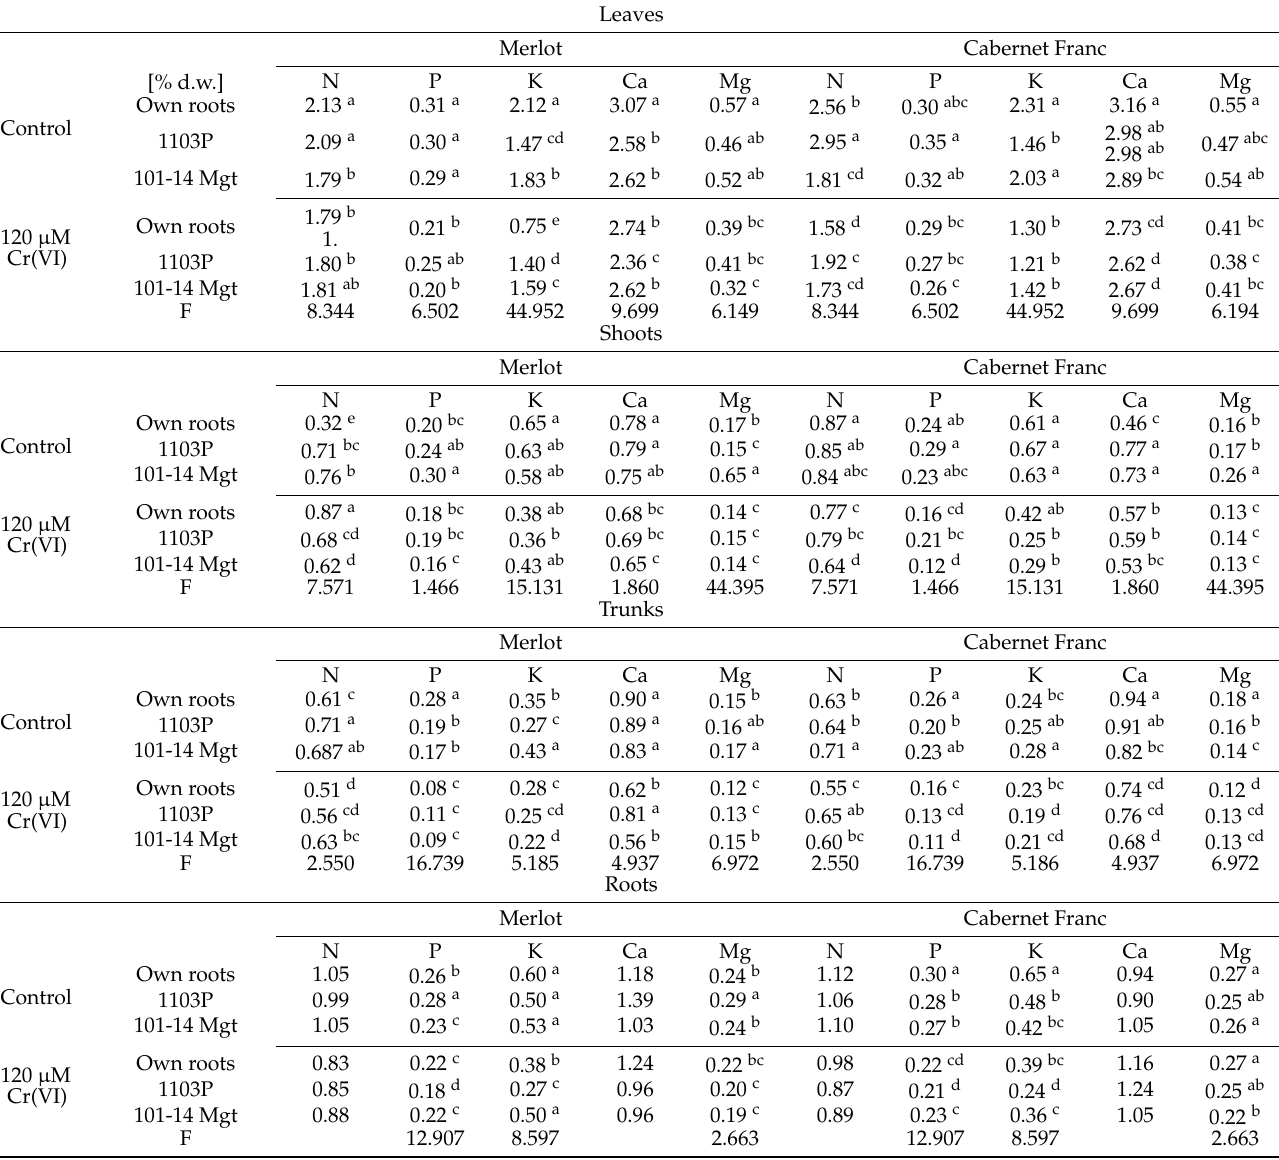
Table 2. The effect of Cr(VI) toxicity on macronutrient (N, P, K, Ca, and Mg) concentrations in different plant compartments of Merlot and Cabernet Franc vines on own roots or grafted to 1103P and 101-14 Mgt rootstocks. Leaves Merlot Cabernet